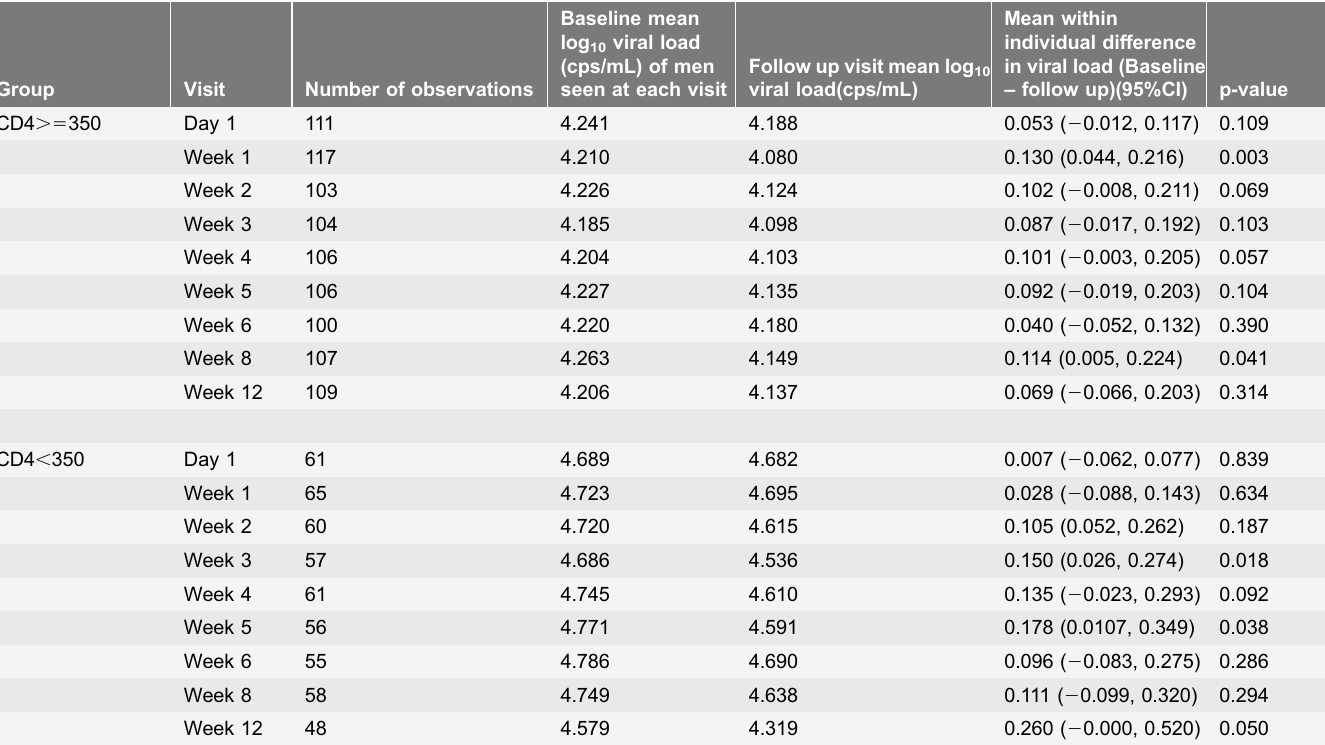
Table 2. Number, Mean log 10 viral loads, mean difference (95%CI) and p values for change in viral load at follow up visits.